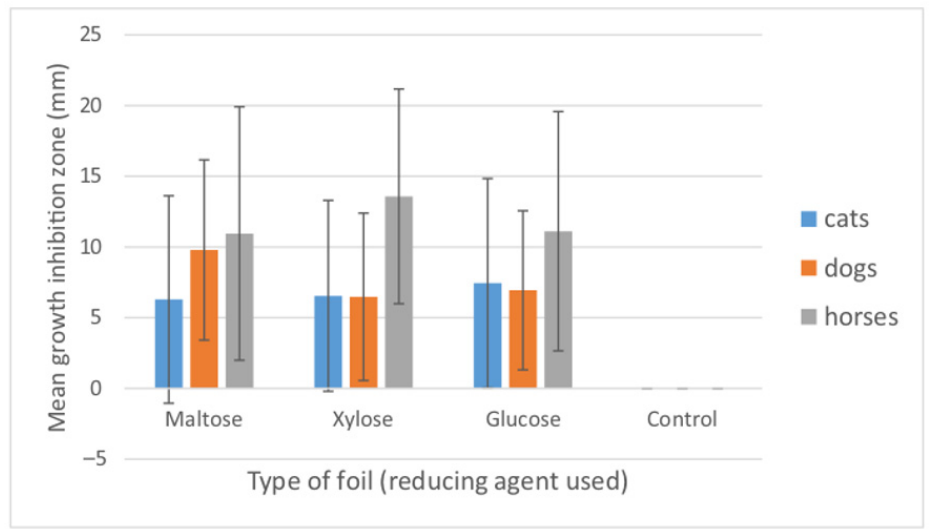
Figure 6. Mean growth inhibition zones (mm) caused by the three types of AgNP-containing foils produced using different reducing agents (maltose, xylose and glucose). The results are means of three replicates of tests conducted for all examined bacterial isolates ( n = 79). Bars represent standard deviation. Control foils (sole alginate) caused no growth inhibition.